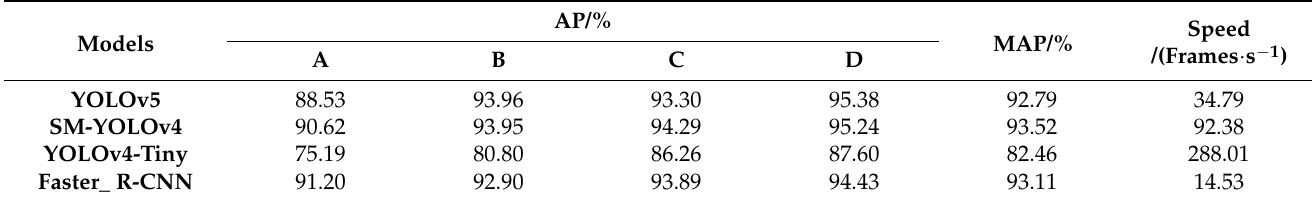
Table 3. Results of grape maturity detection for different trained network